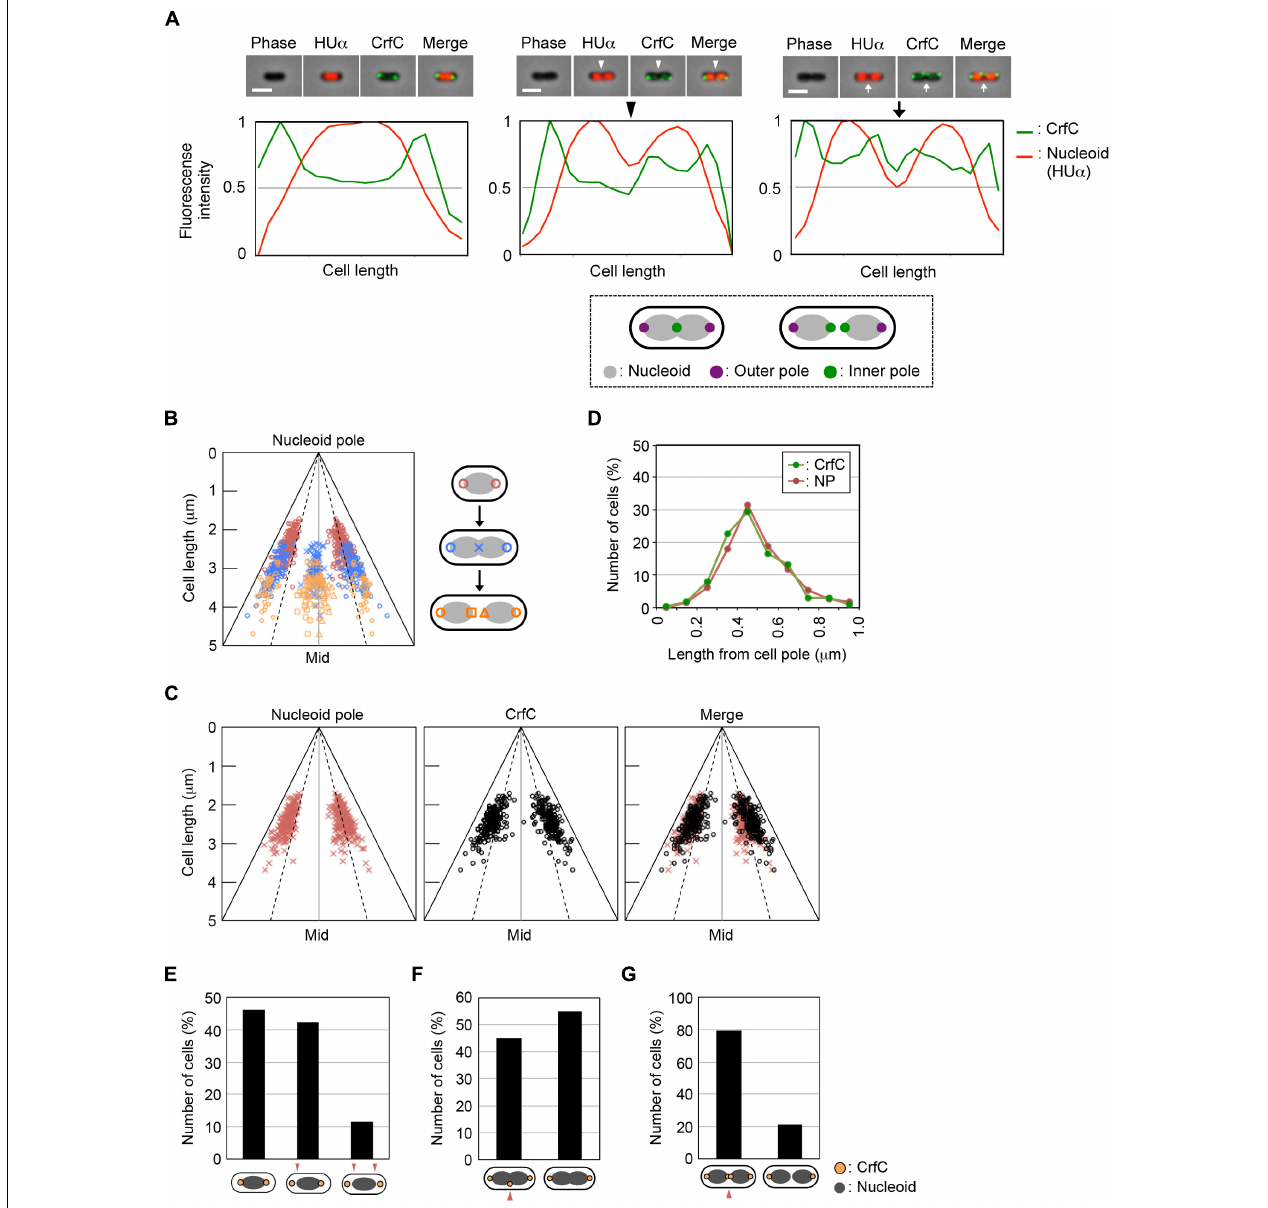
FIGURE 2 | CrfC in the cell-polar area localizes next to the pole of the nucleoid. Fluorescence microscopic analysis of MECS133-K (MG1655 crfC-venus hupA-cfp ) cells to detect CrfC-Venus and nucleoid foci. Cells were grown exponentially at 25 ◦ C in M9glu-caa medium. (A) Snapshot imaging of CrfC-Venus and nucleoid (HU α -CFP) in cells. Normalized fluorescence intensities of CrfC (green line) and the nucleoid (red line) along the length of the cell are shown below each cell image. Scale bar is 2 µ m. Representative images of cells containing a single nucleoid (left panel), a constricted nucleoid (middle panel), or two nucleoids (right panel) are shown. The positions of the outer nucleoid pole (purple circles) and inner nucleoid pole (green circles) are shown in the lower panel. (B) Subcellular positioning of the cell poles in MECS133-K cells. Dotted lines indicate the quarter-cell positions, and black solid lines indicate the positions of the cell poles. Magenta circles indicate nucleoid poles in cells bearing a single nucleoid. Blue circles indicate nucleid poles in cells bearing a constricted nucleoid. Blue cross marks indicate the constriction site of a nucleoid in cells bearing a constricted nucleoid. Orange circles indicate the outer nucleoid poles in cells bearing two nucleoids. Orange squares and triangles indicate the inner nucleoid poles in cells bearing two nucleoids. In total, 326 cells were analyzed. Mid, mid-cell. (C) Subcellular positioning of nucleoid poles (left panel) and cell-polar area CrfC (middle panel) in MECS133-K cells containing a single nucleoid. The merged graph is shown in the right panel. In total, 191 cells were analyzed. Mid, mid-cell. (D) Distance from the cell pole to the cell-polar area CrfC or the nucleoid pole in the cells shown in (C) . Relative CrfC or the nucleoid pole positions were analyzed, and the percentages of cells with the indicated positions are shown. NP, nucleoid pole. (E) Histogram of cells with CrfC foci at positions adjacent to or apart from the nucleoid poles in cells analyzed in (C) . Proportions (%) of cells with two, one or no CrfC foci adjacent to the nucleoid poles are shown. (F) Histogram of the percentage of cells with CrfC foci at the constriction site of the nucleoid. In total, 96 cells bearing a constricted nucleoid were analyzed. (G) Histogram of the percentage of cells with CrfC foci at an inter-nucleoid gap. In total, 39 cells bearing two nucleoids were analyzed.